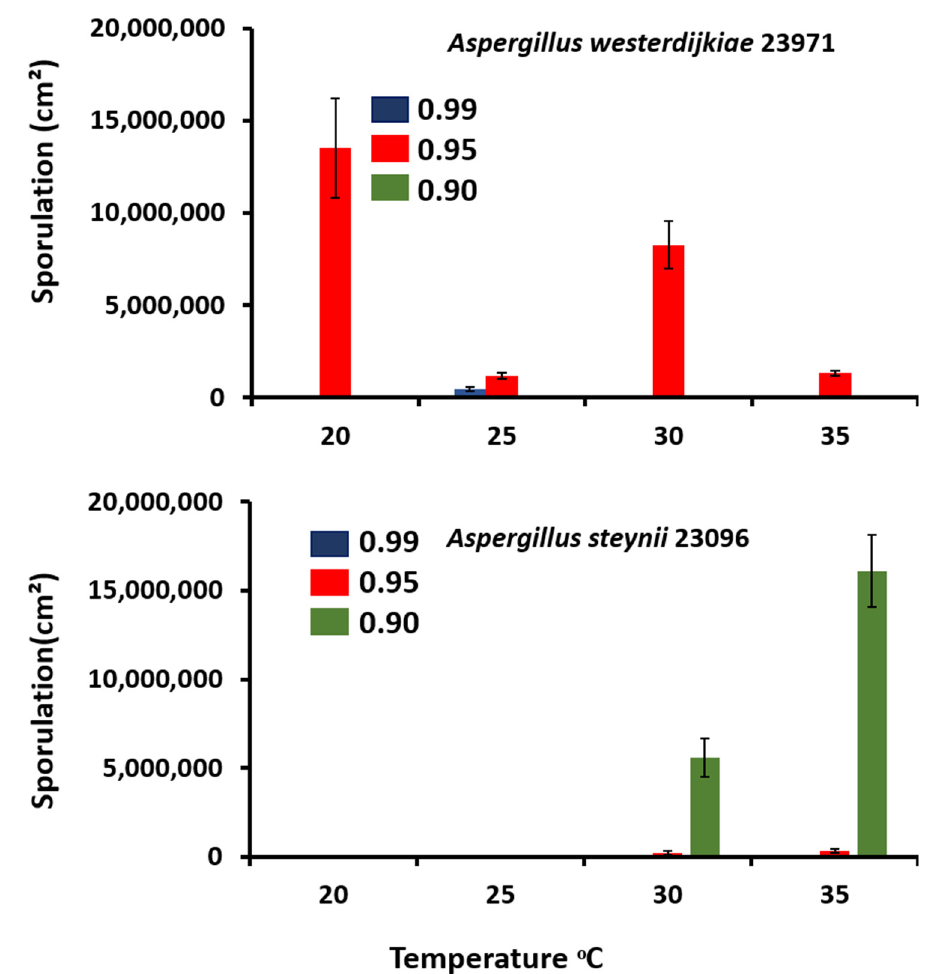
that both conidiation and AFB1 biosynthesis decreased at 0.93 a w when compared to 0.99 a w due to the upregulation of 3156 genes and downregulation of 2206 genes identified between 0.99 and 0.93 a w treatments. They suggested that A. flavus underwent an exten- sive transcriptome response during the variation in water activity levels. Where DF = Degree of freedom; MS = Mean Square; F = Frequency; P = Probability.